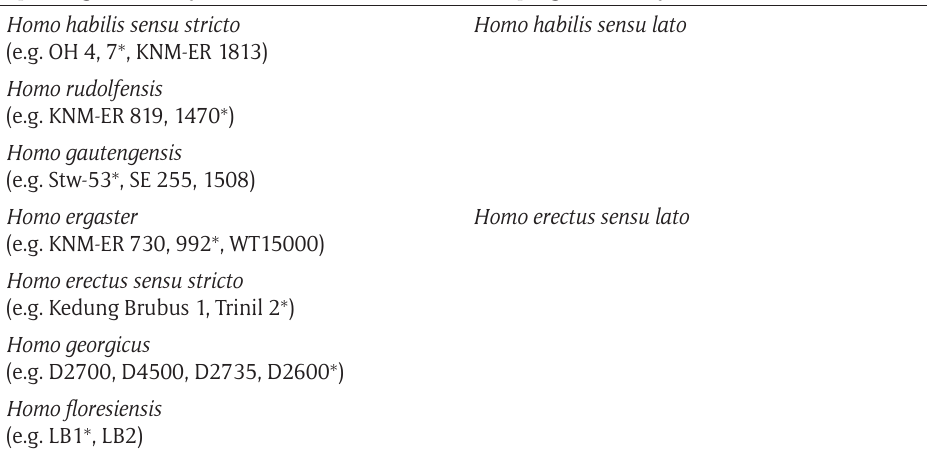
Table 2: The difference in the number of species in ‘early Homo’ based upon a more conservative (‘lumper’) or more speciose (‘splitter’) perspective of hominin diversity (adapted from Wood and Lonergan,